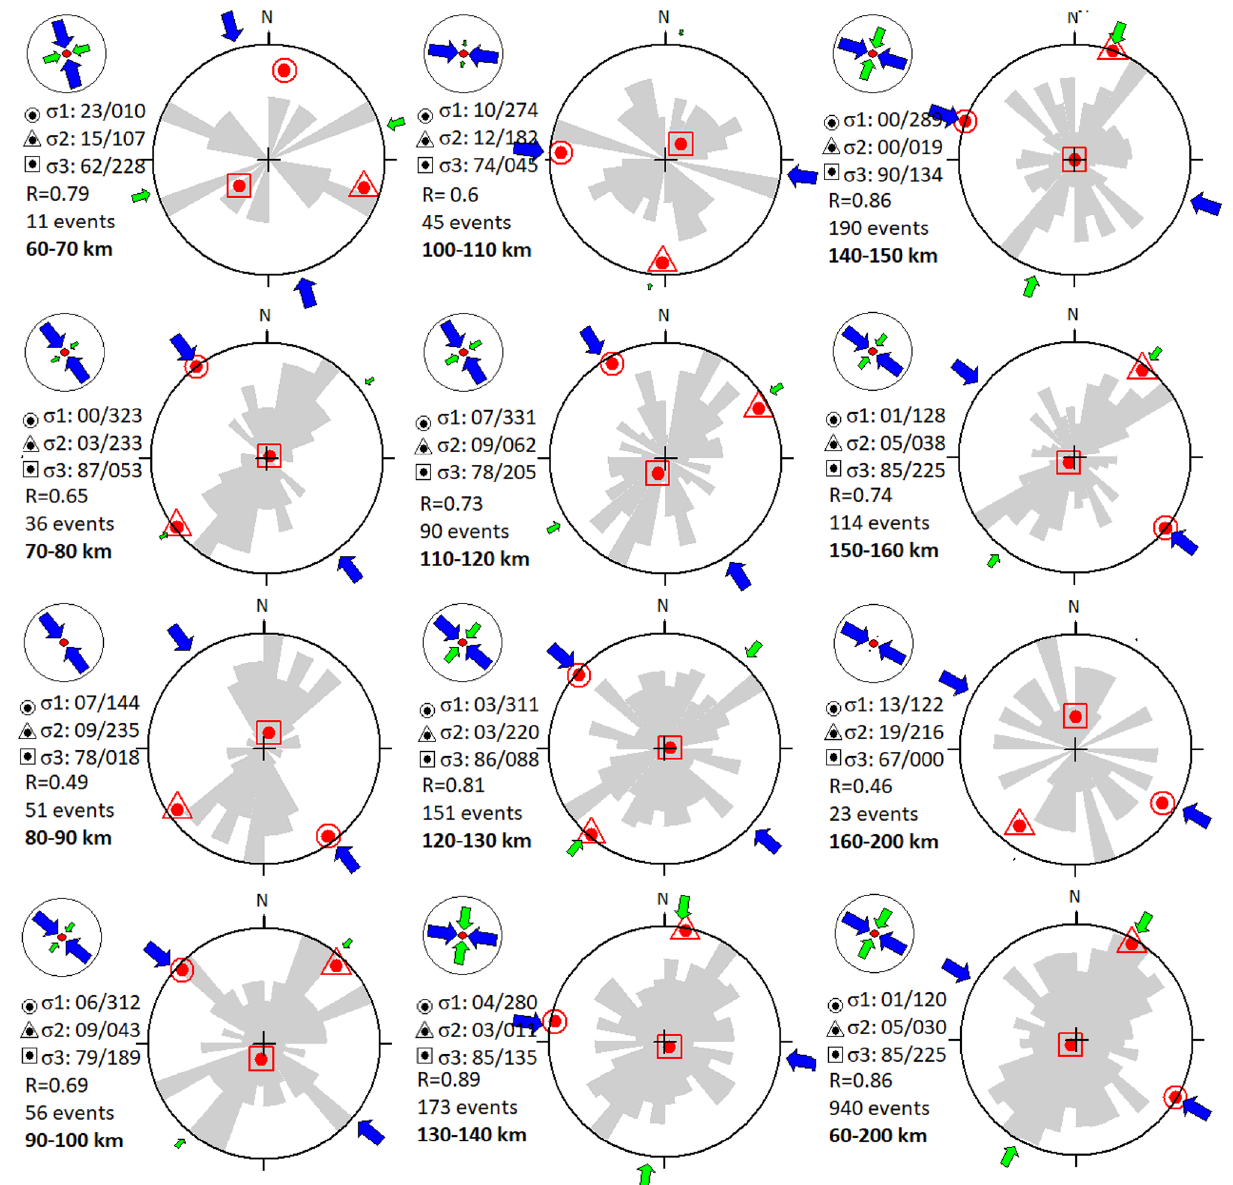
Figure 2. Focal mechanism stress inversion for different depth intervals (every 10 km). Stereograms showing the stress inversion results, including the strike direction of fault plane solutions (grey rose diagram), the stress ratio R (defined in the Methods ) and the number of focal mechanisms for each depth interval. The orientations of the three principal stress axes (plunge/azimuth) are represented with a red circle for σ 1 , a triangle for σ 2 and a square for σ 3 . The axes of the maximum and minimum horizontal stresses Sh max and Sh min are represented by blue and green arrows, respectively. Their type, length and colour symbolise the horizontal deviatoric stress amplitude relative to the isotropic stress ( σ i ), depending on the stress